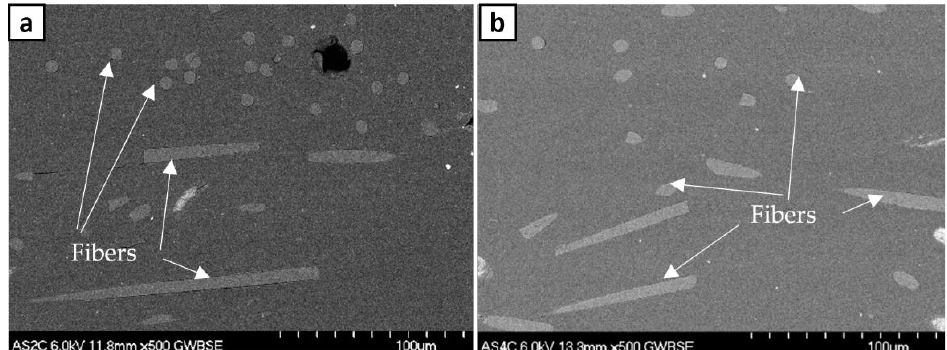
Figure 12. Scanning electron microscope images of carbon fiber distribution in ( a ) 0.2 mm and ( b ) 0.4 mm layer heights.